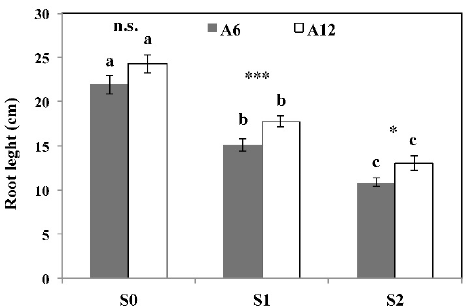
Figure 3. Roots length (cm) in response to different salinity levels (S0, S1, and S2) of two accessions A6 and A12. a–c: the letters denote statistically significant differences among salinity levels for each accession ( p = 0.01; SNK test); the stars denote statistically significant differences between the two accessions for each salinity level (* p = 0.05; ** p = 0.01; *** p = 0.001, n.s. not significant; t ‐ test). Table 4. Total biomass (mg ∙ plant − 1 on dry weight) in response to different salinity levels.